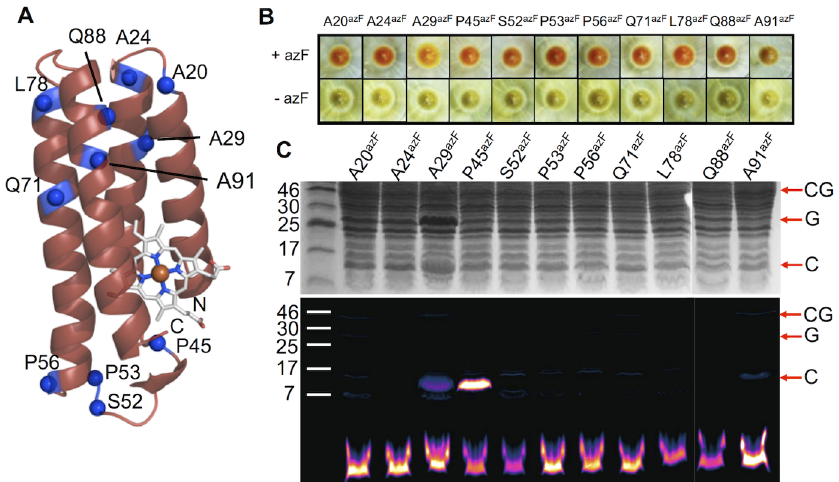
Fig 4. Production and conjugation of cyt b 562 azF-containing variants. (A) Schematic structure of cyt b b 562 showing the residues substituted with azF. (B) Expression of cyt 562 variants housed in the pIFtag plasmid in the presence (+azF) or absence (-azF) of azF. Cells successfully expressing functional cyt b 562 display a red phenotype. (C) SDS-PAGE analysis of SPAAC conjugation. The top panel shows the Coomassie Blue stained and the bottom is fluorescence imaging of the DBCO-585 moiety. CG, G and C refer to cyt b 562 -sfGFP fusion, sfGFP and cyt b 562 , respectively. The lower band is unreacted DBCO-585. For the sake of transparency, the samples Q88 and A91 were run on separate gels to the others and the resulting images electronically linked to the other